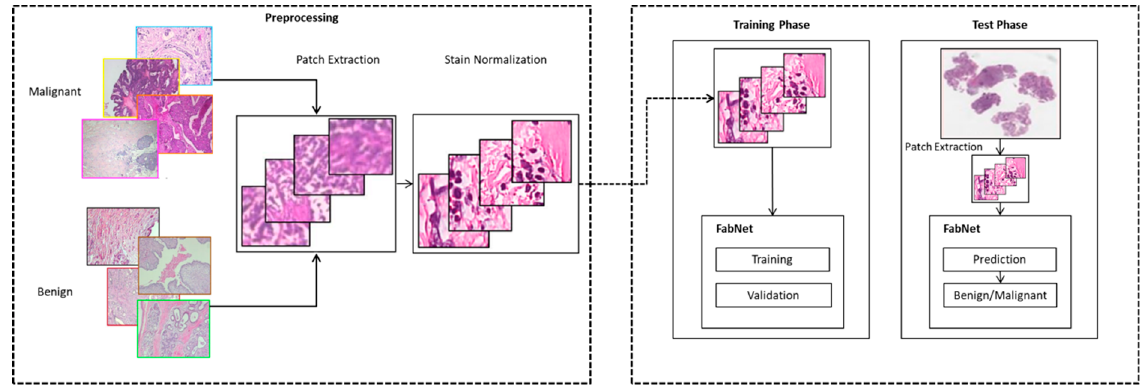
Figure 3. An overview of the proposed methodology to classify the histopathological